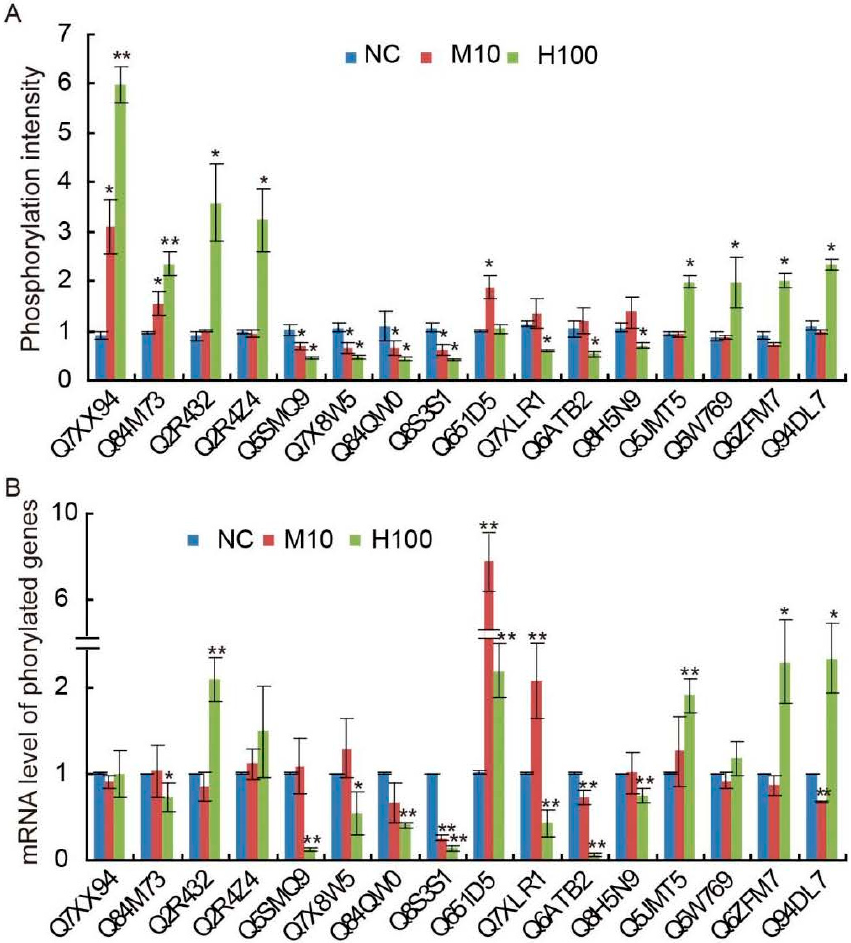
Figure 6. The relationship between ( A ) phosphorylation intensity and ( B ) transcript abundance, based on the response of 16 genes encoding differentially phosphorylated proteins. Values are means ± SD ( n = 3); the asterisks indicate statistical significance between the M10, H100 and NC, as determined by Student’s t -test (* p ≤ 0.05; ** p ≤ 0.01).